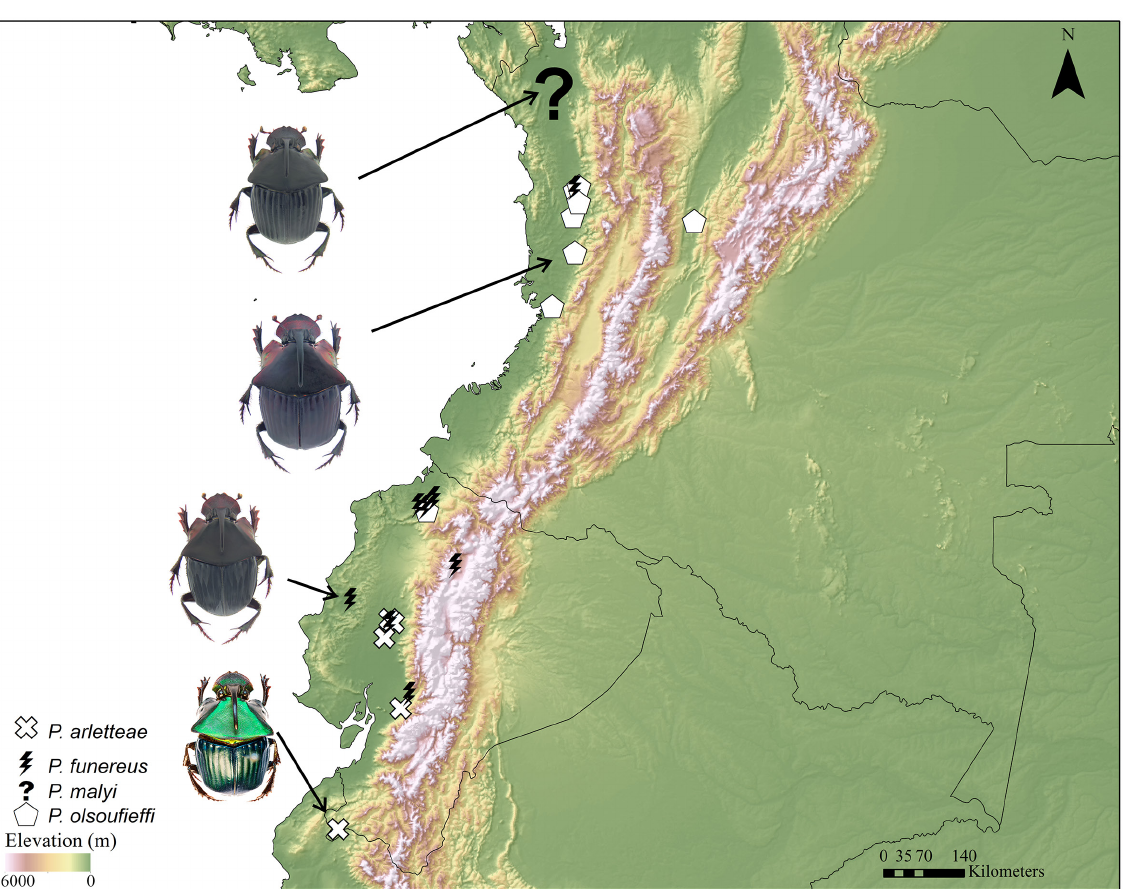
Fig. 17. Distribution of the Phanaeus endymion species group in South America. Phanaeus malyi Arnaud, 2001 was reported from Colombia without accurate locality. Phanaeus arletteae Arnaud, 2018 was modified from